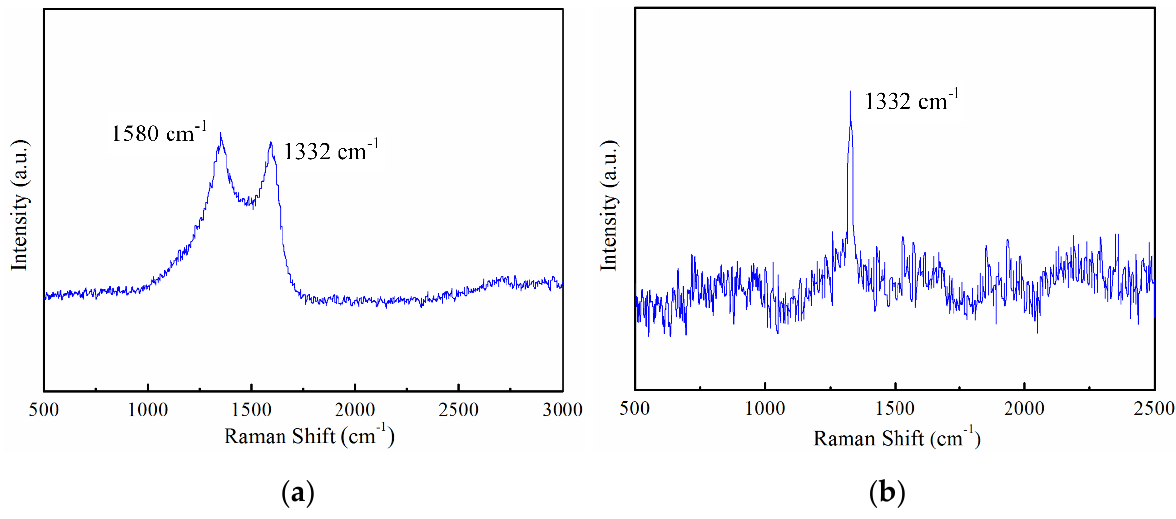
Figure 4. Raman spectra of tool surfaces before and after grinding. ( a ) Before grinding; ( b ) After grinding.